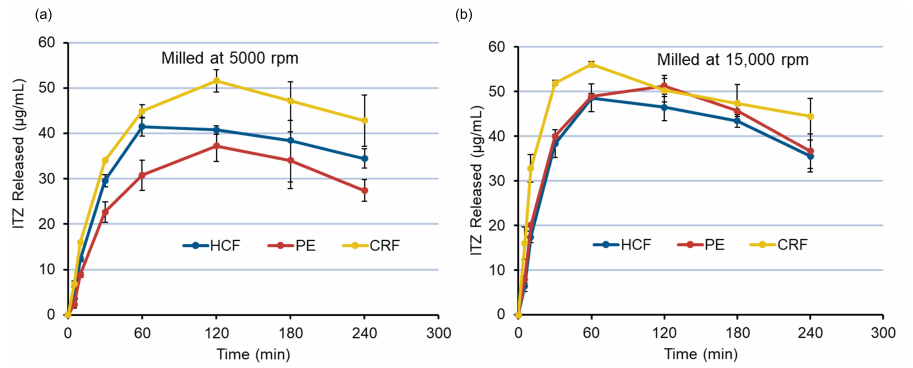
Figure 10. Dissolution of ITZ from ASD tablets using different feedstocks. ( a ) Feedstocks milled at 5000 rpm using a 1 mm mesh screen. ( b ) Feedstocks milled at 15,000 rpm using a 1 mm mesh screen. PSDs of milled extrudates at both milling speeds (5000 and 15,000 rpm) are summarized in Table